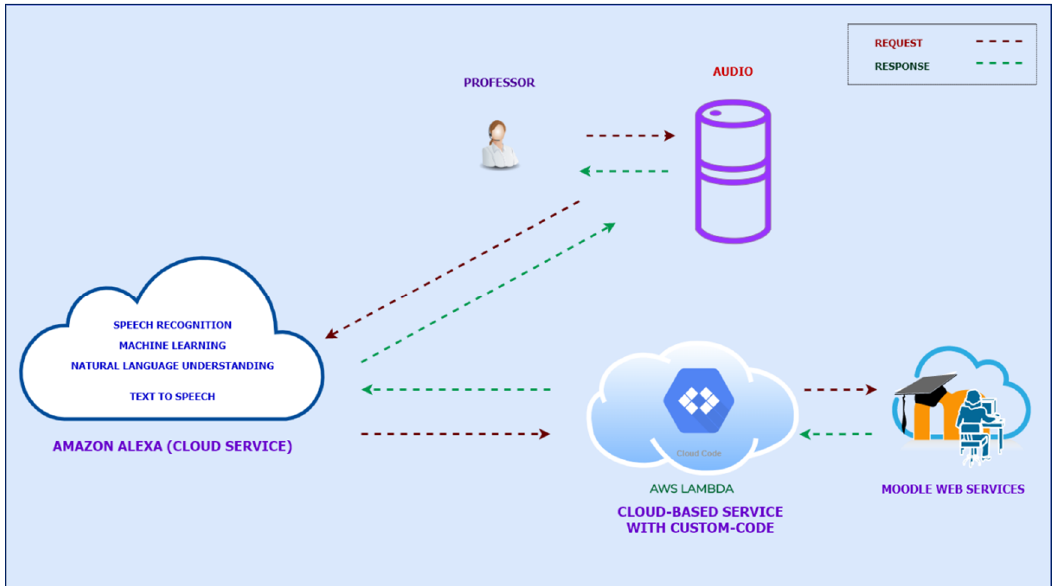
Figure 2. Diagram of the operation of the “UBUVoiceAssistant” application from Moodle.